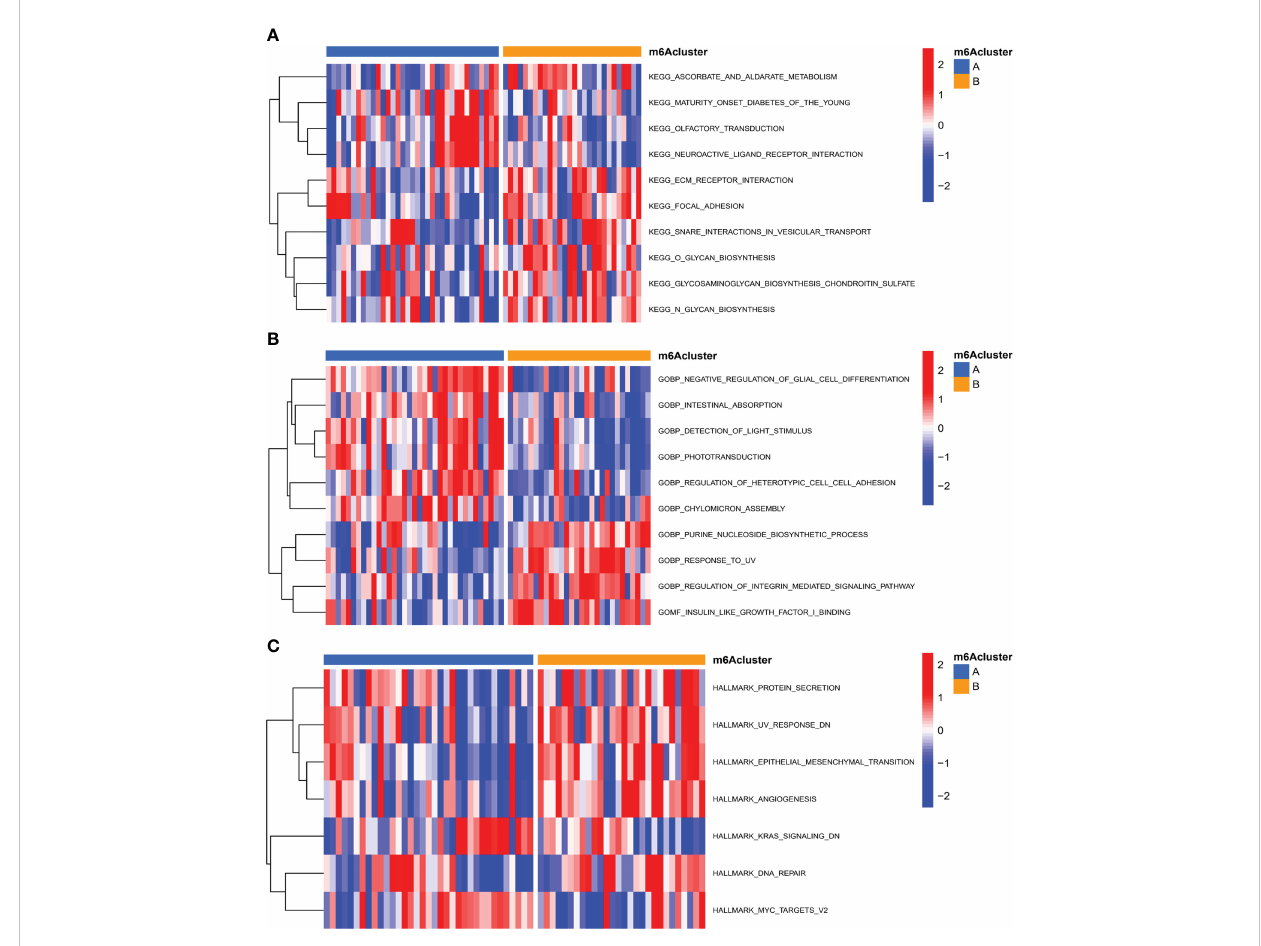
FIGURE 7 Functional analysis of different m6A RNA methylation modi fi cation patterns in OA. (A) Differences in KEGG pathway enrichment scores. (B) Differences in GO pathway enrichment scores. (C) Differences in Hallmark analysis